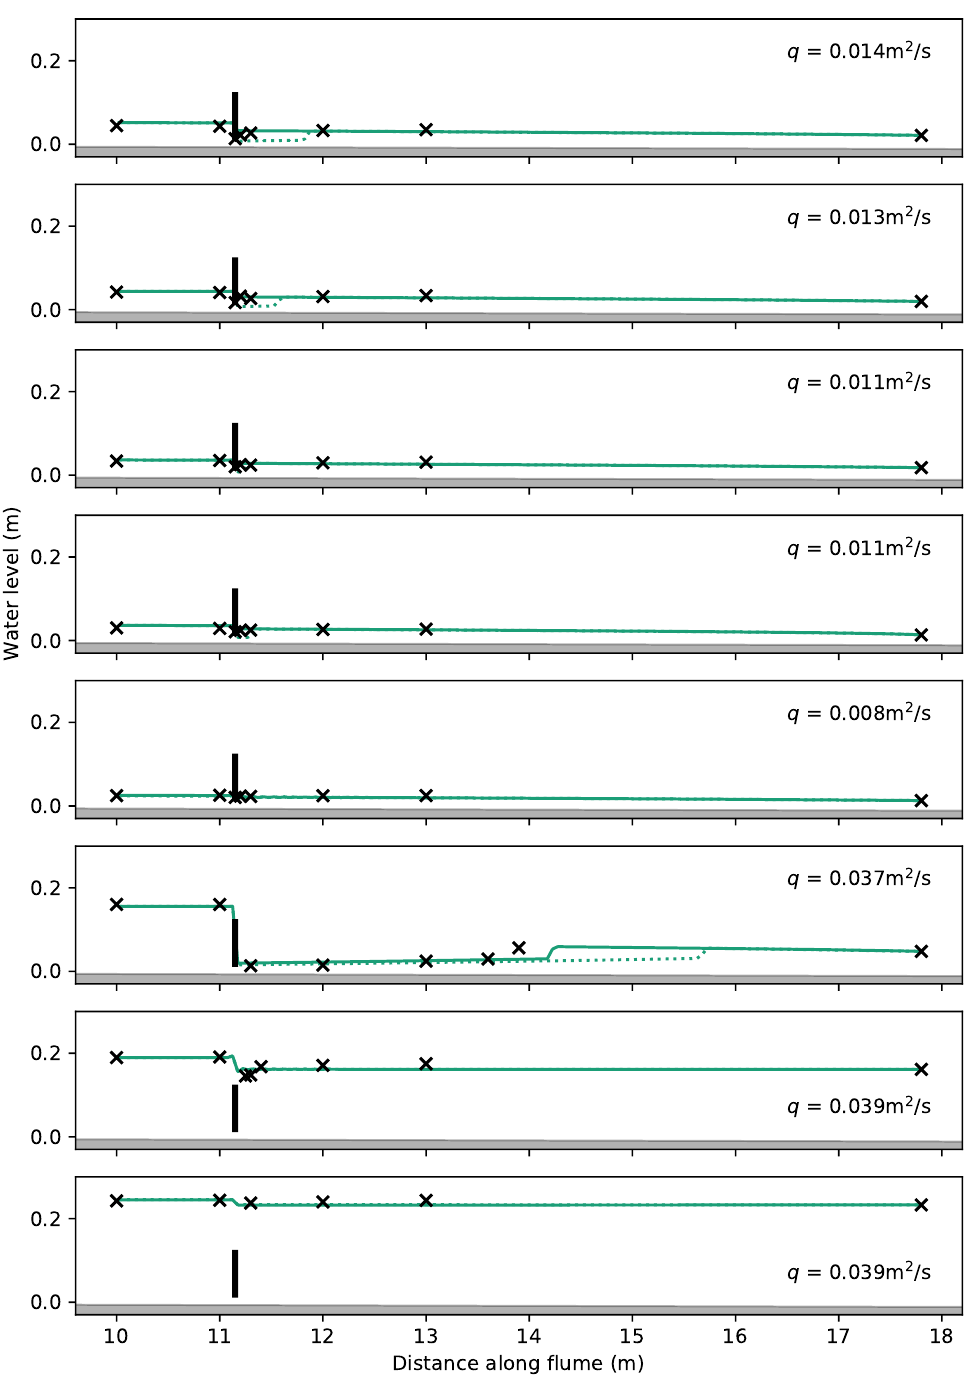
Figure A8. Results for configuration